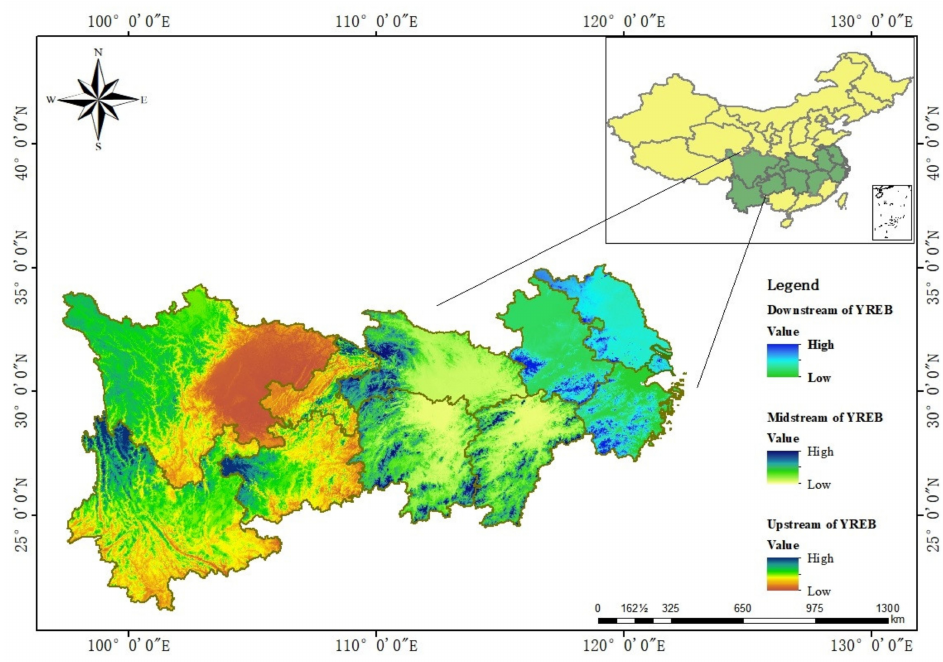
Figure 1. The location map of the study area.